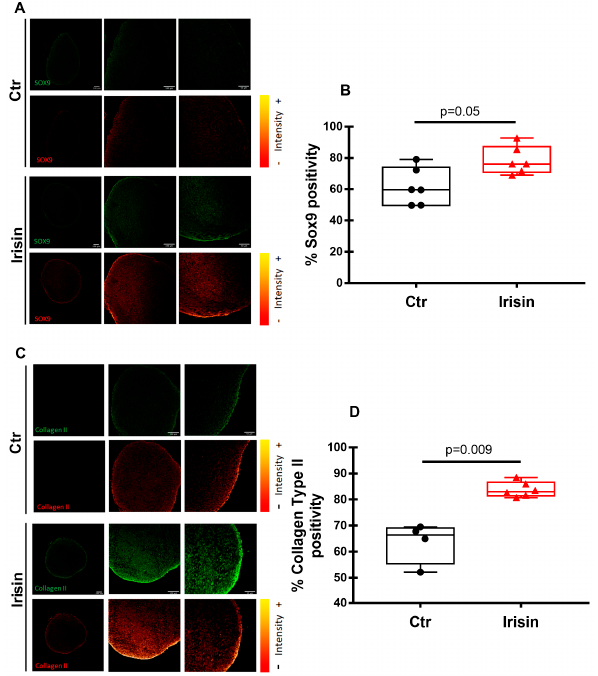
Figure 5. Immunofluorescence analysis of the chondrogenic markers in HAC pellets. Indirect immunofluorescence staining of Sox ‐ 9 ( A ) and Collagen II ( C ) in HAC pellets, treated with Irisin and Ctr, after 21 days of chondrogenic differentiation. For each panel, upper row: pellets stained for Sox ‐ 9 and Collagen II, green color represents the positive reaction. Lower row: lookup table displaying the localization of Sox ‐ 9 and Collagen II, the color bar on the right reflects the range of pixel intensities from red (lower) to yellow (higher). The figures are representative of four to six separate experiments. Dot ‐ plot graphs showing the quantification of % positivity of Sox ‐ 9 ( B ) and Collagen II ( D ). Data are shown as box ‐ and ‐ whisker plots with median and interquartile ranges, from max to min. A Mann–Whitney test was used to compare the groups.